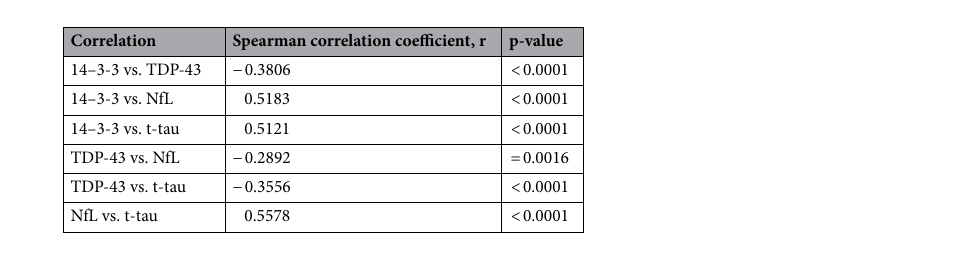
Table 3. Correlations with significant results. TAR DNA binding protein (TDP)-43; neurofilament light chain (NfL); total-tau (t-tau).